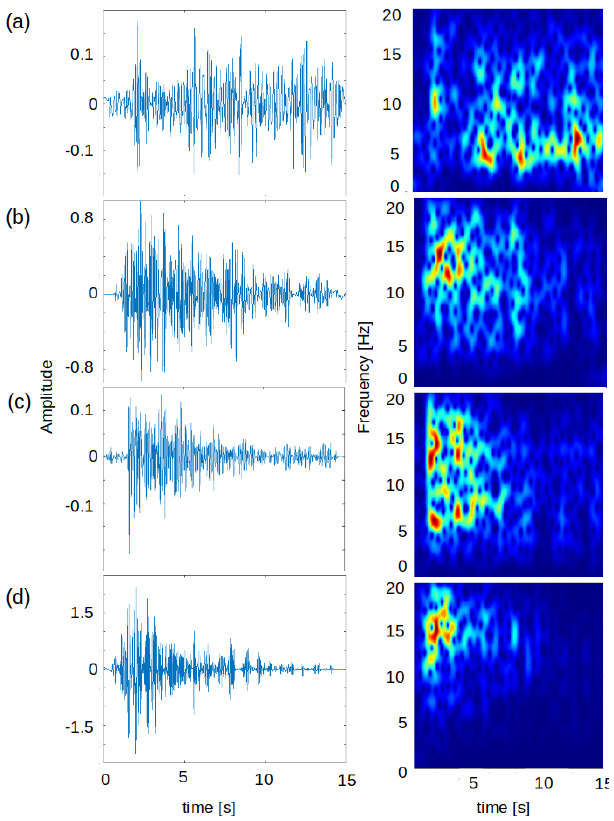
Figure 3. Station selection for each event: example of station selec- tion for the VT event that occurred on 3 April 2018 22:58:44UTC, the event was recorded by the stations (a) LC01, (b) LC03, (c) LC04, and (d) LC07. The spectrogram of the station LC07 was selected for its frequency content.